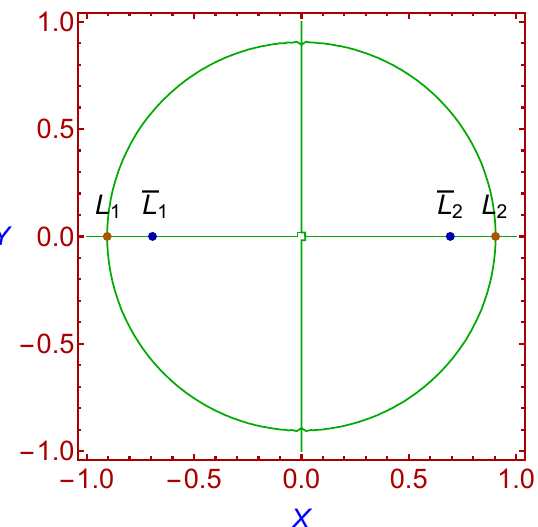
Figure 1. Locations of equilibrium